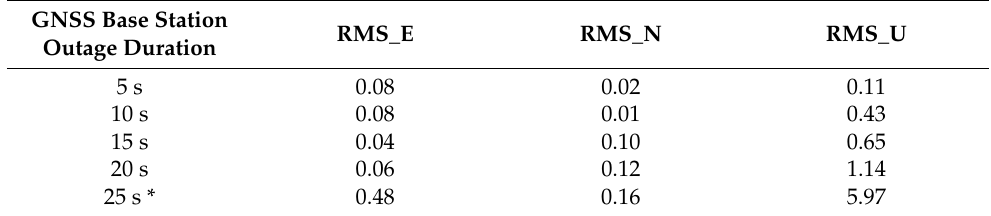
Figure 8. Coupled displacement results of the simulated landslide stability period in Scene 2.1. Table 6. RMS statistical results when simulating the landslide stability period in Scene 2.1 (unit: cm). GNSS Base